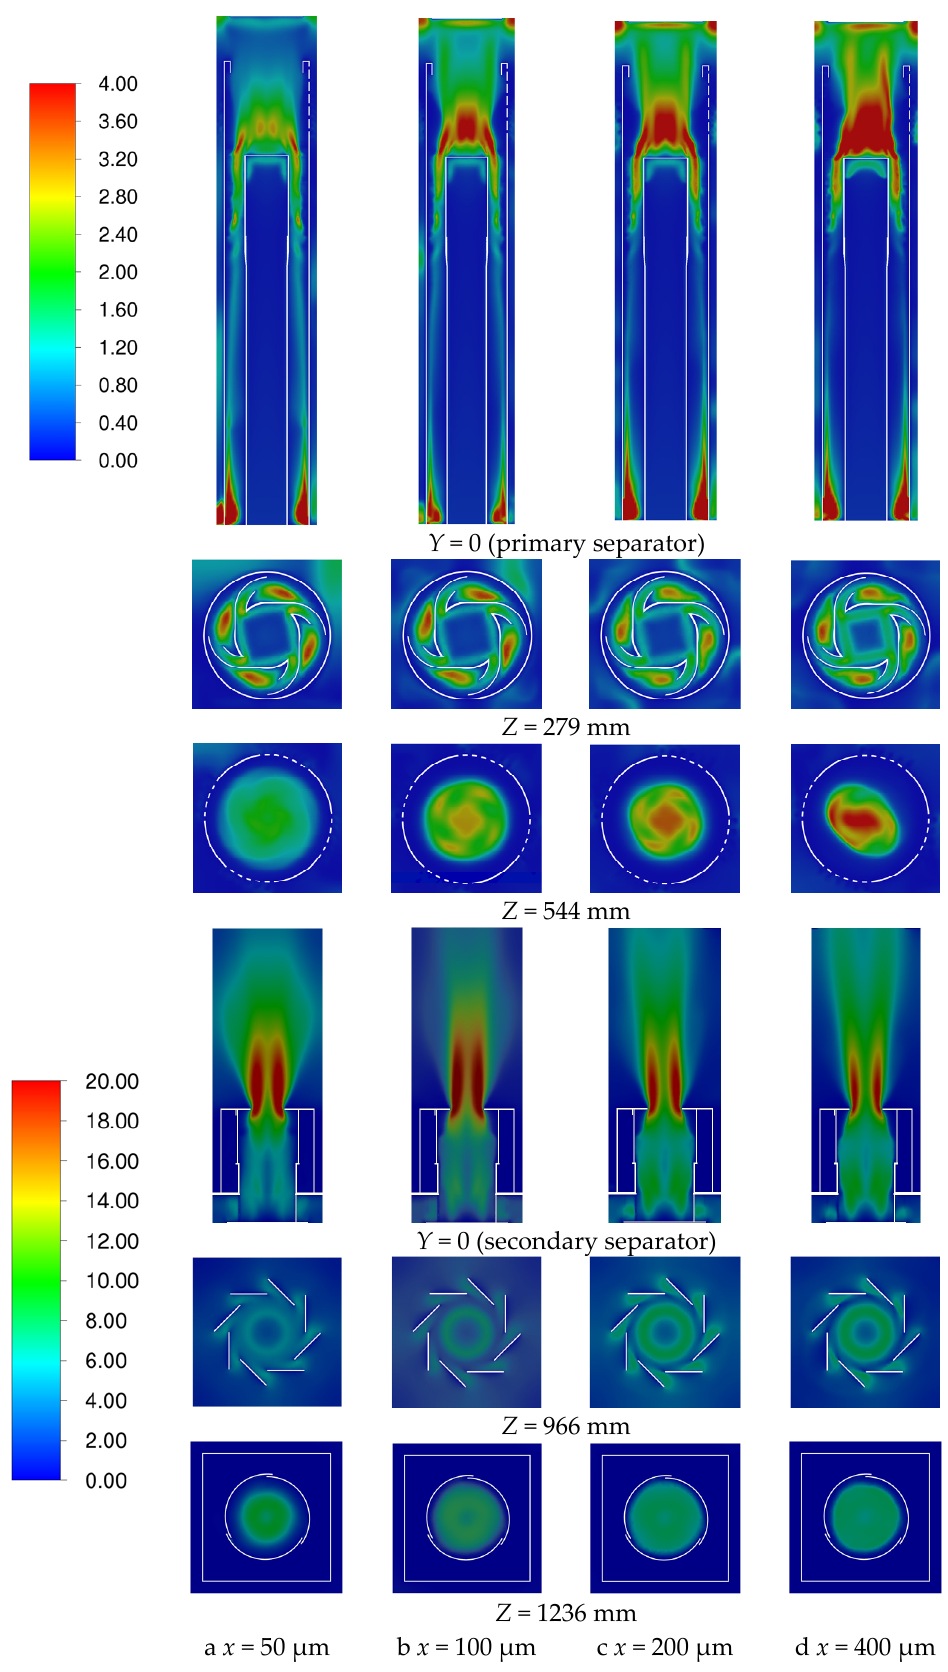
Figure 8. Turbulent kinetic energy distribution of steam-water mixture (unit: m 2 /s 2 ).